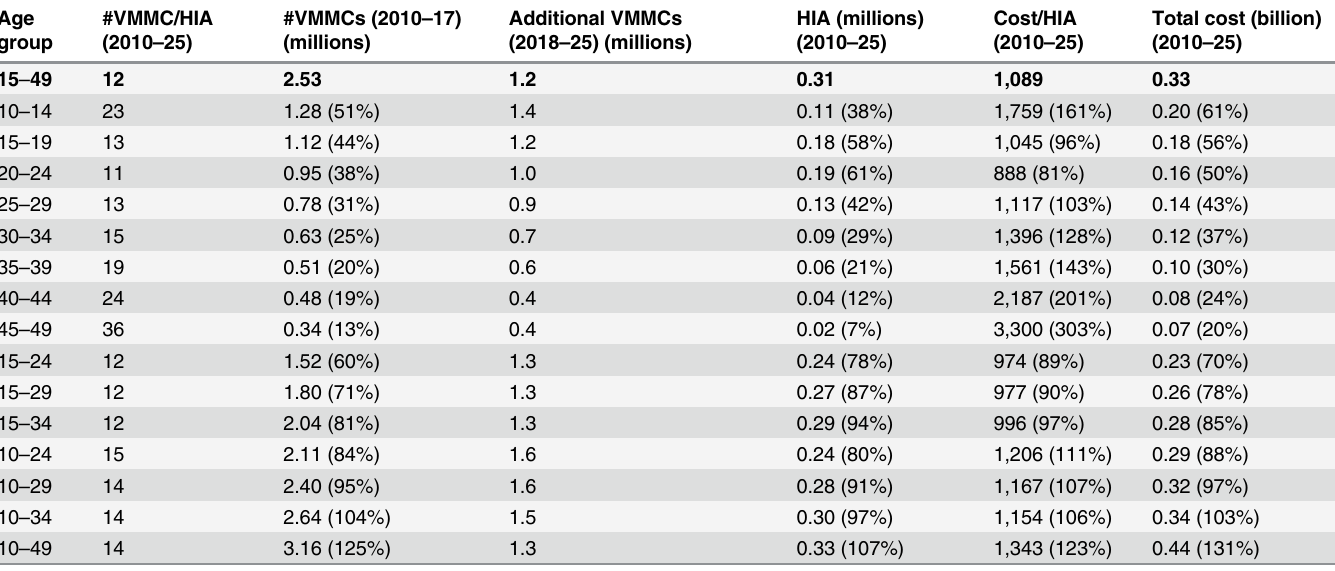
Table 1. Epidemic impact of prioritizing different age groups in the voluntary medical male circumcision (VMMC)